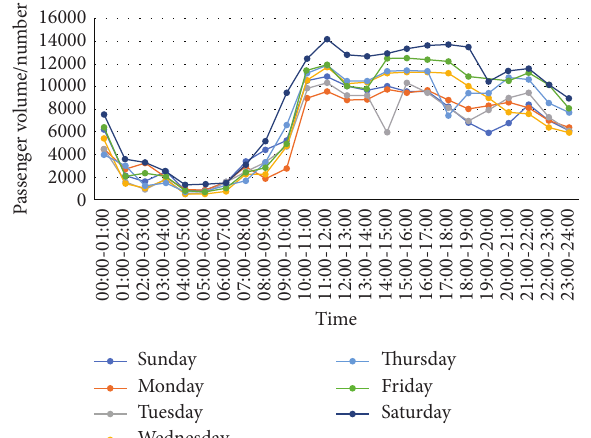
Figure 5: Graph of average passenger